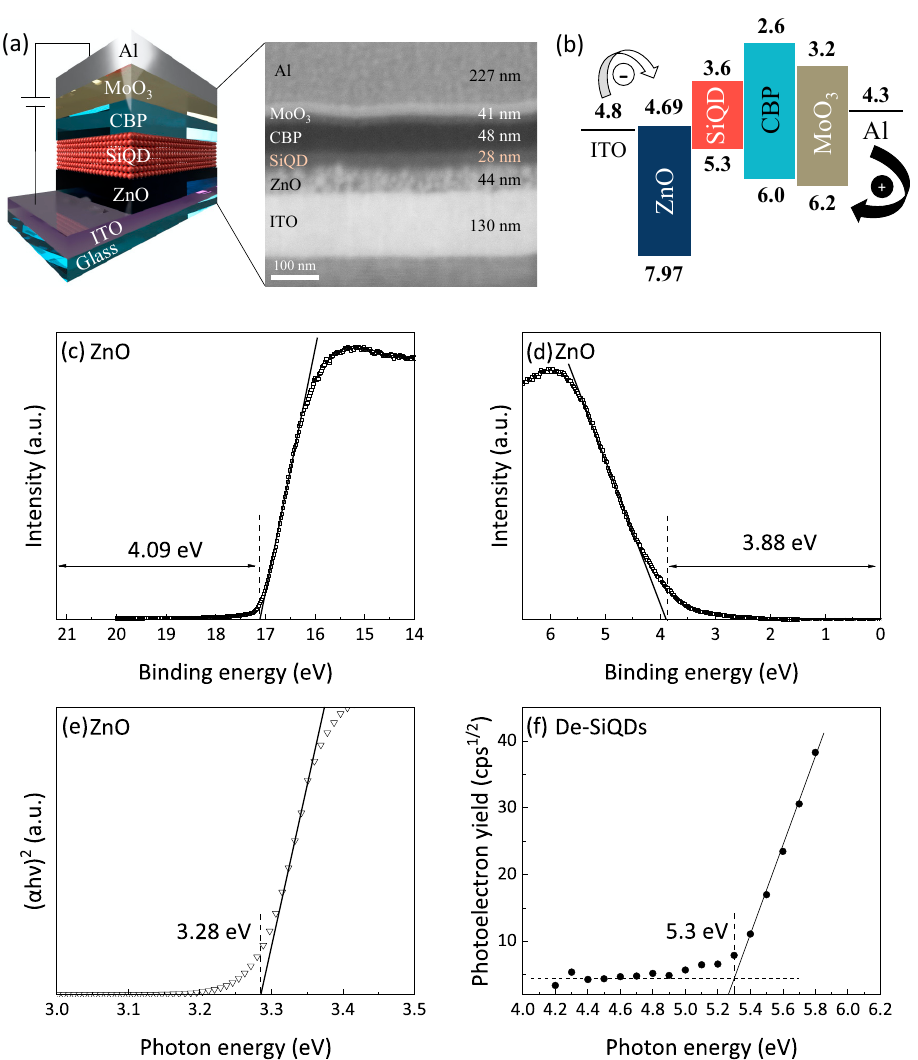
Figure 2. ( a ) Schematic illustration of Si-iQLEDs stack structure and a cross-sectional SEM image of the device structure with a hybrid organic/inorganic multilayer stack, ( b ) flat energy band diagram in the unbiased conditions. UPS spectra of ( c ) secondary-electron cutoff and ( d ) valence-band edge regions of ZnO thin film. ( e ) ( α h ν ) 2 − h ν plots converted from the absorption spectra of ZnO nanoparticles. ( f ) Photoelectron yield spectroscopic (PYS) spectrum of thin film of De-SiQDs.